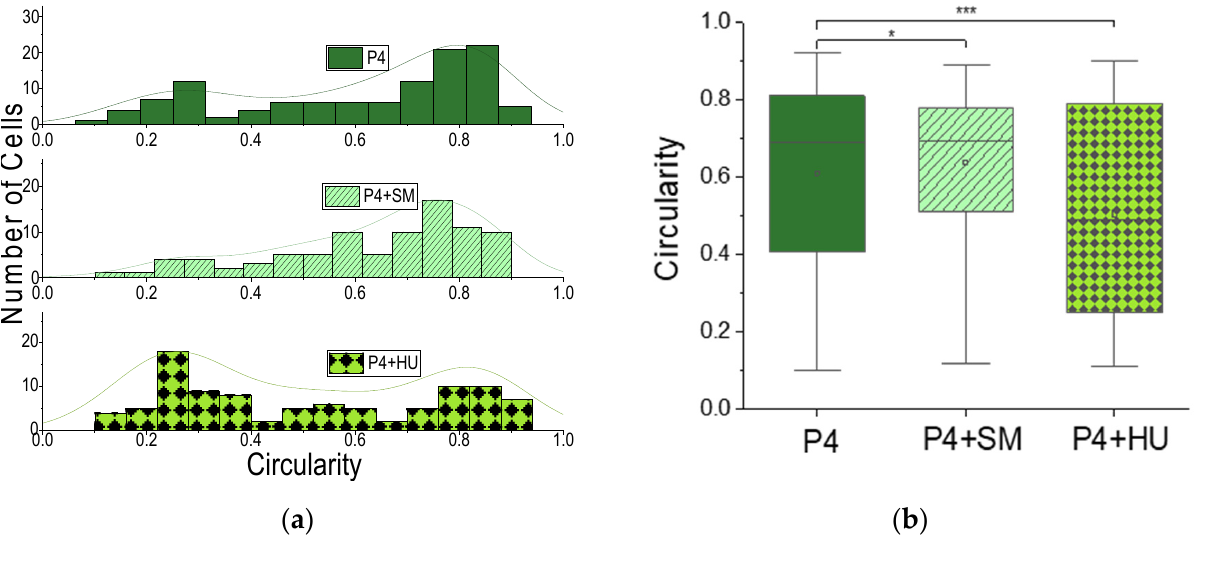
Figure 3. Morphometry of cells from MMM outlet: circularity. ( a ) Histogram of circularity (Equation (1)) and kernel smooth curves for RBCs from patient 4, showing morphological heterogeneity in untreated cells, P4; in cells treated with sodium metabisulfite, P4 + SM; and cells treated with hydroxyurea, P4 + HU. ( b ) Box plots for the circularity data in ( a ). Cell numbers ( n ) and circularity ( C ) for each condition are: P4, n = 114, C = 0.61 ± 0.02; P4 + SM ( n = 88, C = 0.64 ± 0.02); and P4 + HU ( n = 9, C = 0.50 ± 0.03). One-way ANOVA shows statistically significant (*** p < 0.001) differences between P4 and P4 + HU and (* p < 0.05) between P4 and P4 + SM.